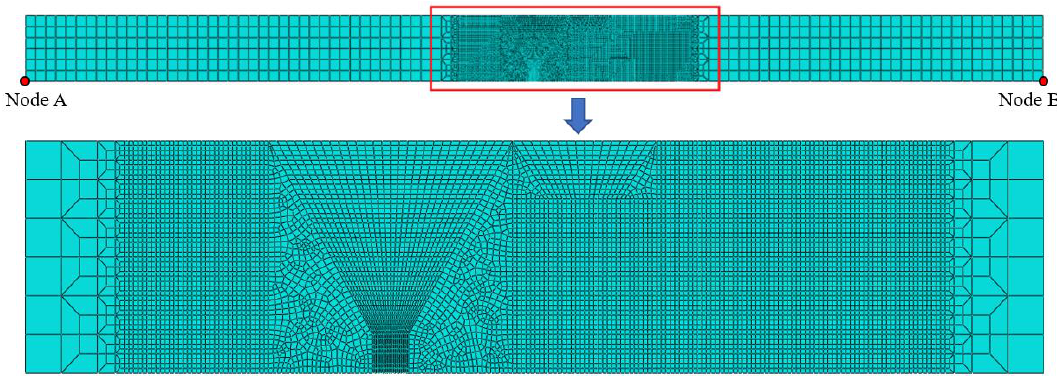
Figure 5. Finite element (FE) model and meshing.